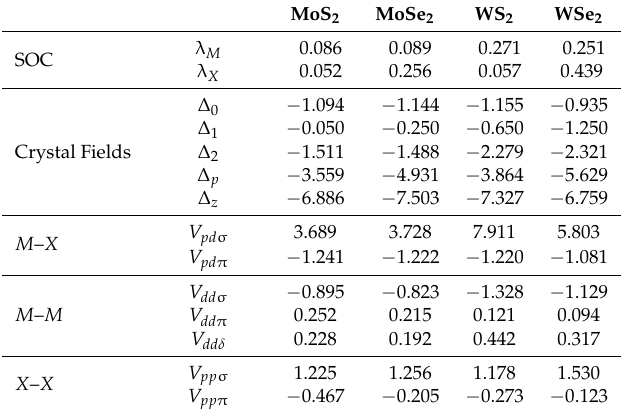
Table 2. Spin–orbit coupling λ α and tight-binding parameters for single-layer MX 2 , where the metal M is Mo or W and X is S or Se. All of the Slater–Koster parameters are in units of eV. Spin-Orbit (SO) coupling parameters are taken from Reference [37].